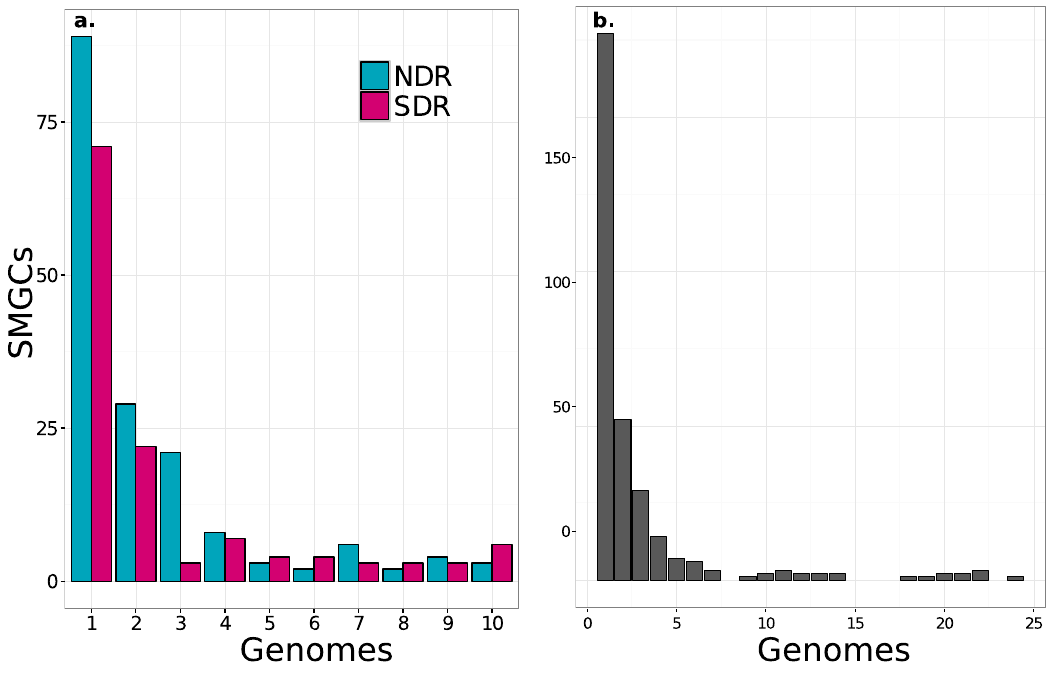
Figure 4. The frequency distribution of SMGCs across strains shows that most SMGCs are strain-specific and fewer are species-specific. Results are shown both for NDR and SDR. ( a ) and for all 24 genomes; ( b ). Non-redundant orthologous SMGCs were defined using our annotation-independent approach (see Materials and Methods).